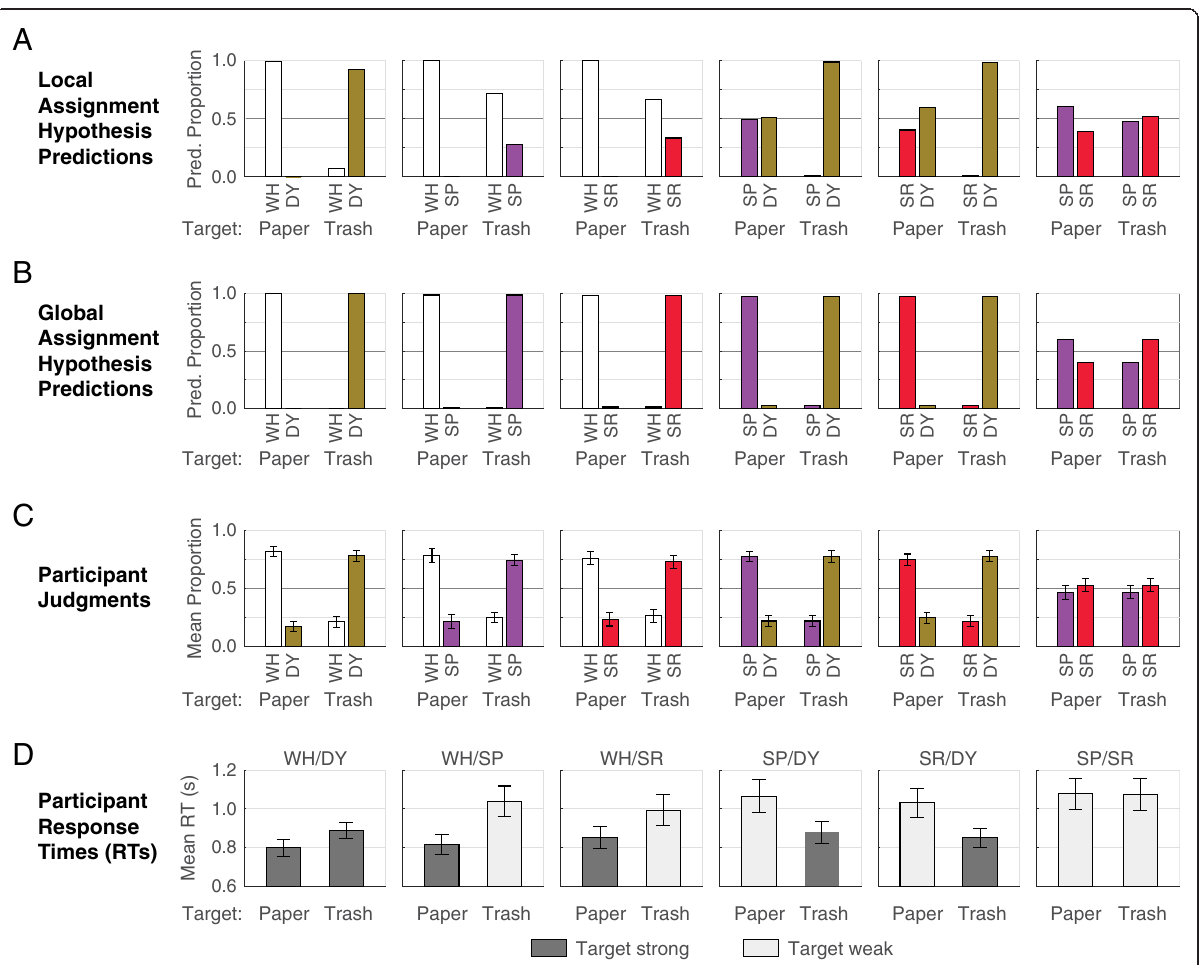
Fig. 6 Predictions from ( a ) the local assignment hypothesis and ( b ) the global assignment hypothesis in terms of the proportion of times each color would be chosen for each target object ( x-axis ) within each color set (separate plots ). The model predictions were generated from the color-object association data shown in Fig. 4. c The mean proportions of times participants chose each color for each target within each color set. d The corresponding mean response times (RTs) plot for each object within each color set. Error bars represent±the standard errors of the